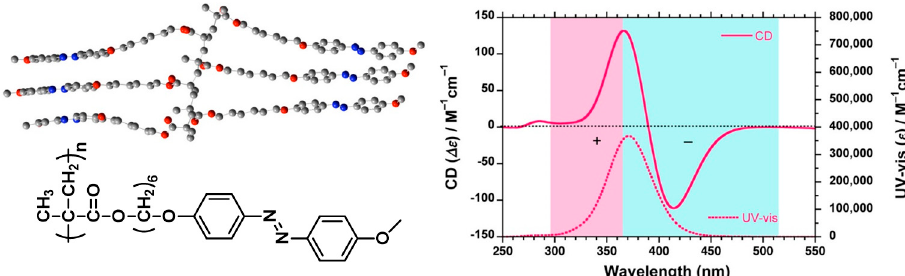
Figure 17. Six slightly twisted trans -Azo side chains and simulated CD and UV-vis spectra of the model. (Reprinted with permission from [231]; Copyright (2017) American Chemical Society).